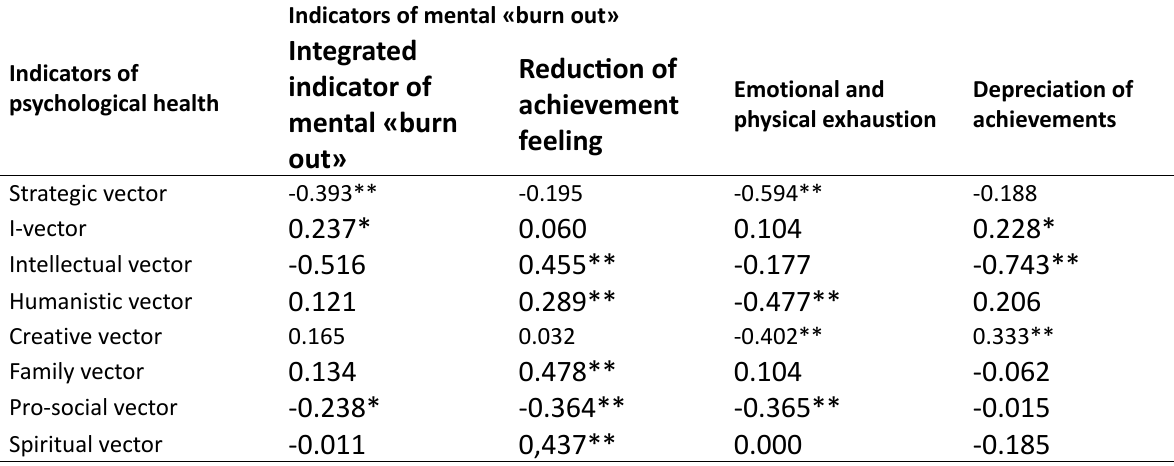
Table 2. Correlation coefficients between indicators of mental “burn out” and psychological health in high qualification athletes sample